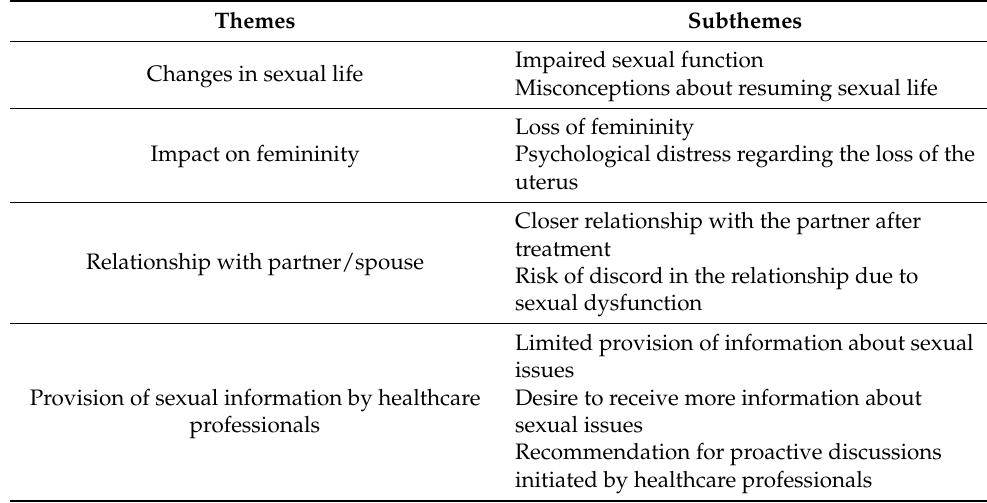
Table 2. Themes and subthemes generated in this